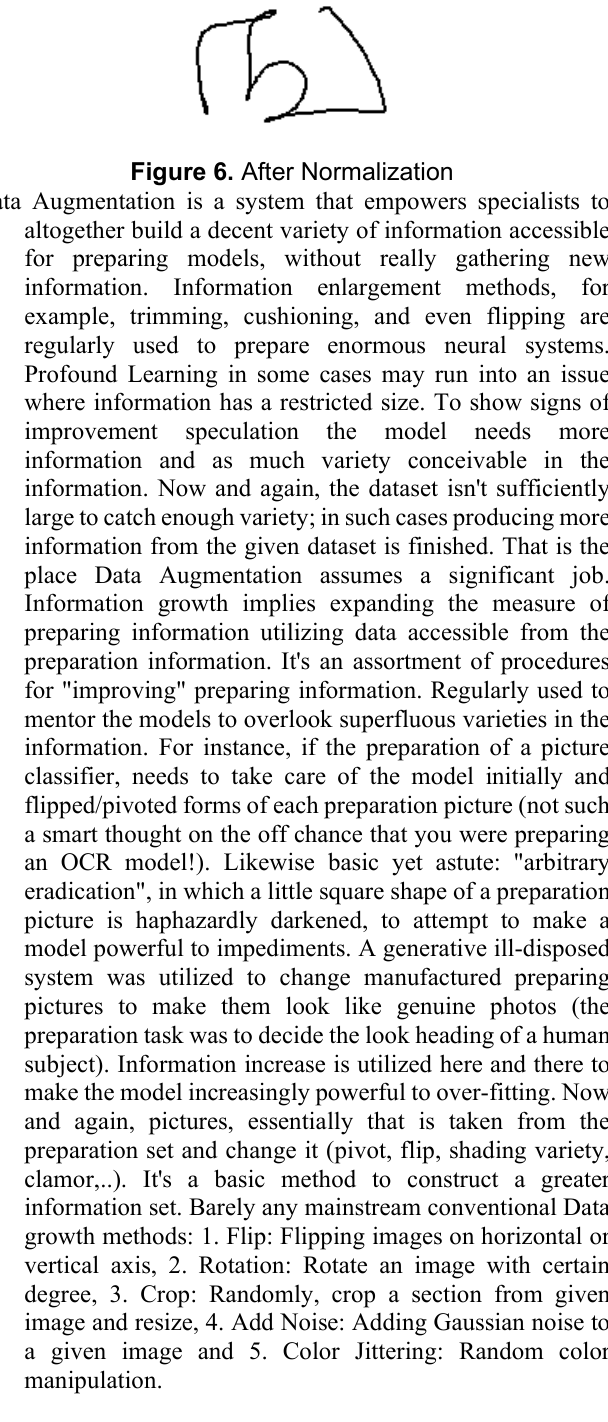
Figure 5. Before Normalization